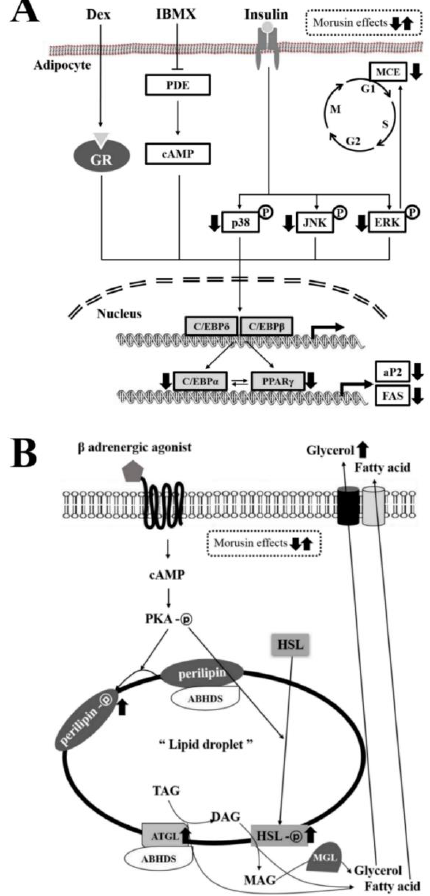
Figure 7. Suggested mechanism of action of morusin in MDI-stimulated 3T3-L1 cells and primary adipocytes. In this scheme, ( A ) anti-lipogenic effects of morusin are thought to be exerted via the inhibition of adipogenic transcription factors and lipogenic proteins, recovery of G0/G1 arrest in cell cycle, and the regulation of the MAPK signaling pathway. ( B ) Anti-lipolytic effects of morusin are thought to stimulate the activation of lipolytic proteins.